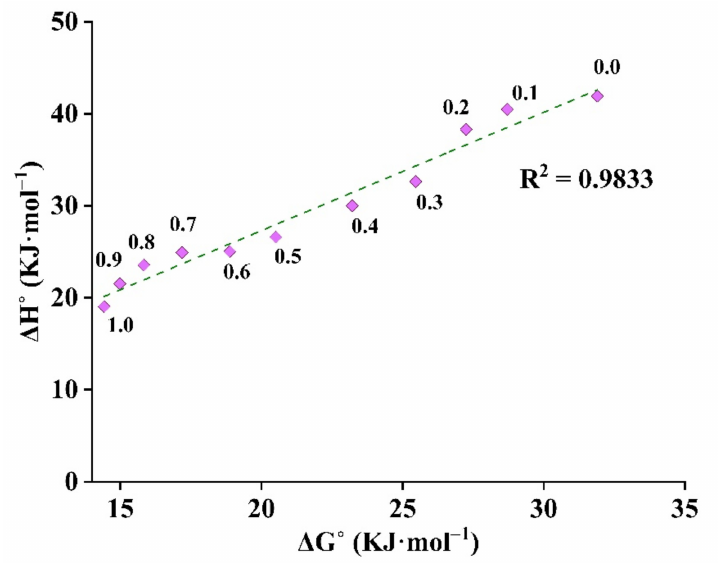
Figure 5. Enthalpy–entropy compensation analysis in different mole fractions of THP in the TWM binary mixture at T hm of 308.15 K. The mole fraction of THP in TWM mixture was represented from 0.0 to